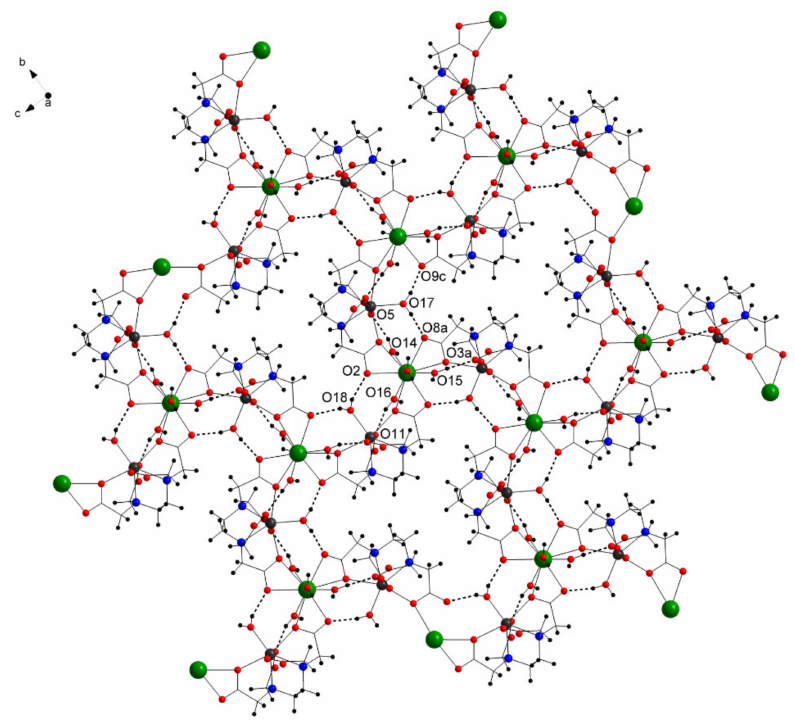
Figure 4. View of the layer framework and the intramolecular hydrogen bonds (dotted lines) along the a axis in 1 (free water molecules omitted for